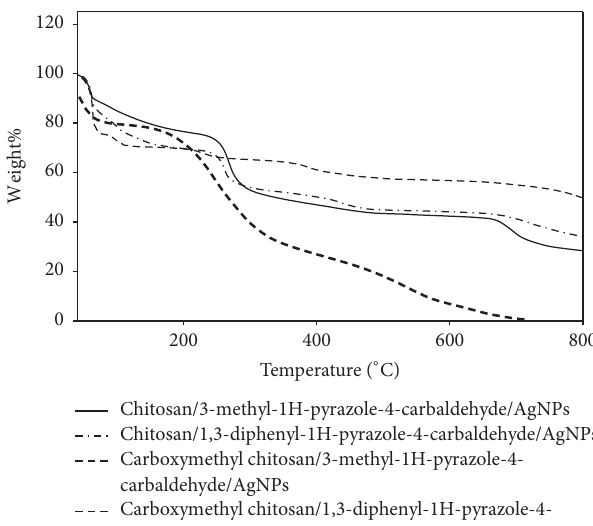
Figure 5: TGA of CS or CMCS/Schiff-bases loaded with AgNPs.